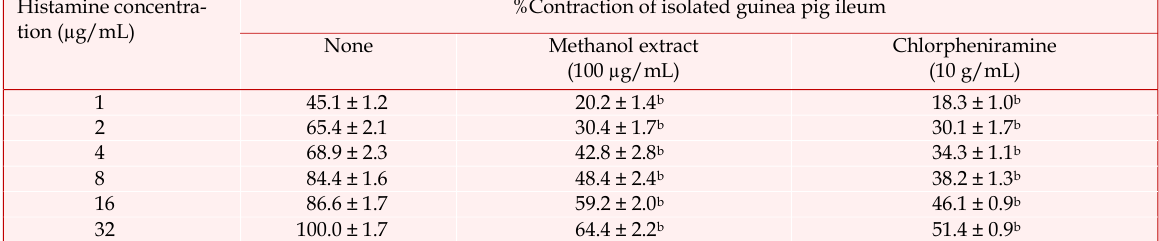
Effect of methanol extract of the tuber of Stephania glabra on histamine-induced contraction in isolated Histamine concentra- tion